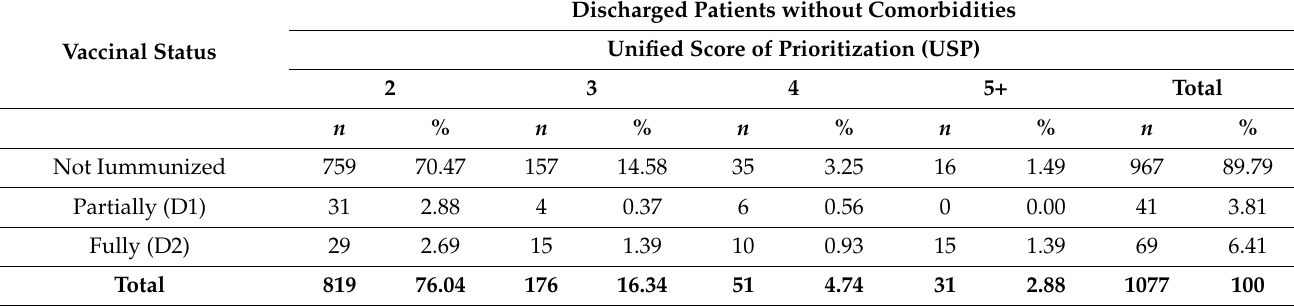
Table 1. Discharged patients without comorbidities admitted between June to August 2021 and grouped according to their vaccinal status and the Unified Score for Prioritization